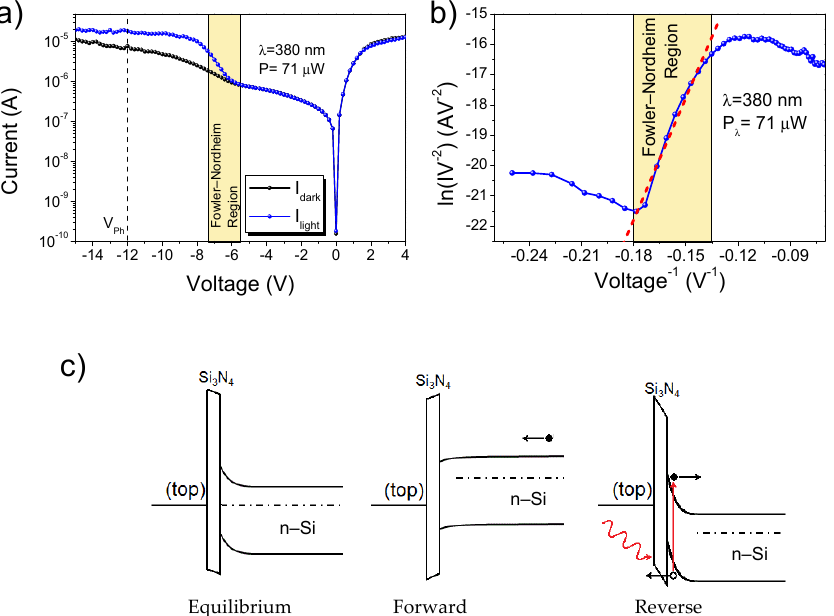
Figure 2. ( a ) I–V characteristic of the device in the dark and under illumination by a 380 nm LED. V ph is the voltage used to estimate the photocurrent. ( b ) Fowler–Nordheim plot of the blue curve in ( a ). ( c ) Band structure of the MIS junction formed between the nanotubes, the silicon nitride, and the n-doped silicon at equilibrium, forward, and reverse bias. In the reverse bias condition, the photogenerated holes inside the silicon can tunnel through the triangular-shaped barrier of the silicon nitride, giving rise to a photocurrent. We chose a value of V Ph in the plateau region in reverse bias (Figure 2a) to obtain the quantum efficiency map. Figure 3a shows the efficiency map obtained from a device with a pristine MWCNT film. It is possible to see that the photo-response is different from zero only when the light spot is focused on the MWCNT film area. The efficiency of the device was almost constant along the MWCNT film, but along the top and bottom edges, it showed a higher response. To understand this behavior, we looked at the CNT film with a scanning electron microscope. Figure 3b shows the top-right corner of the MWCNT film. It can be observed that the film thickness on the upper edge slowly decreased until no nanotubes were present, while on the right edge, the thickness rapidly changed to zero. Comparing the map with the SEM images, it is clear that the regions with higher QE are associated with the regions with thinner MWCNT film.